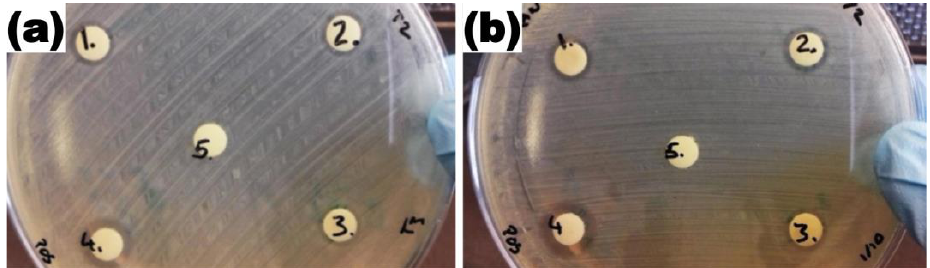
Figure 5. ( a ) Concentrated USP triplicates ( 1 ), one-in-two dilution ( 2 ) and one-in-ten dilutions ( 3 ), commercial AgNPs ( 4 ) and DI water ( 5 ). ( b ) Zones of inhibition for LASiS recirculatory flow AgNPs concentrated ( 1 ), one-in-two dilution ( 2 ) and one-in-ten dilutions ( 3 ), commercial AgNPs ( 4 ) and DI water ( 5 Table 1. Comparison of the size of AgNPs produced through different methods and the zone of inhibition exhibited by AgNPs on E. coli cells.